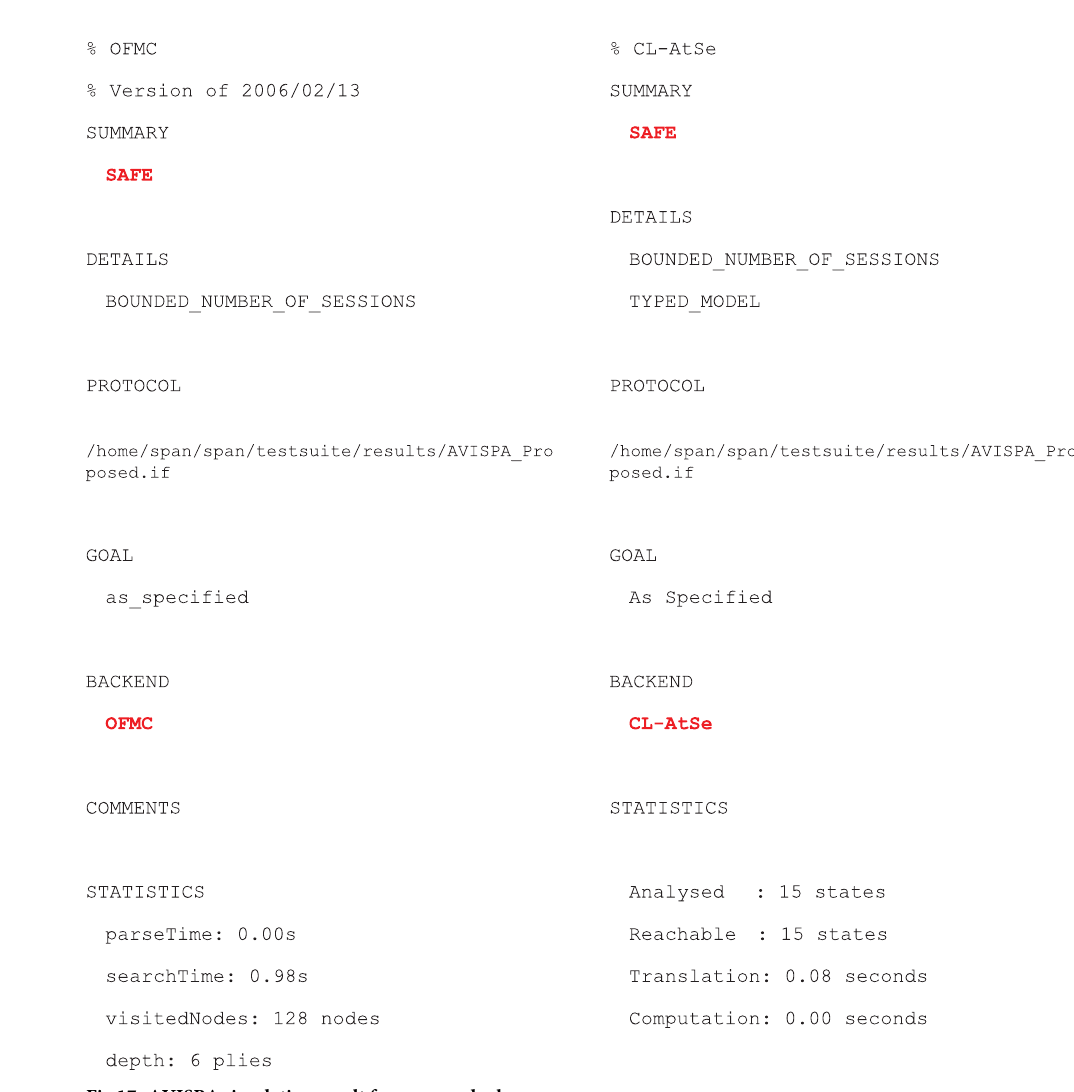
Fig 17. AVISPA simulation result for proposed